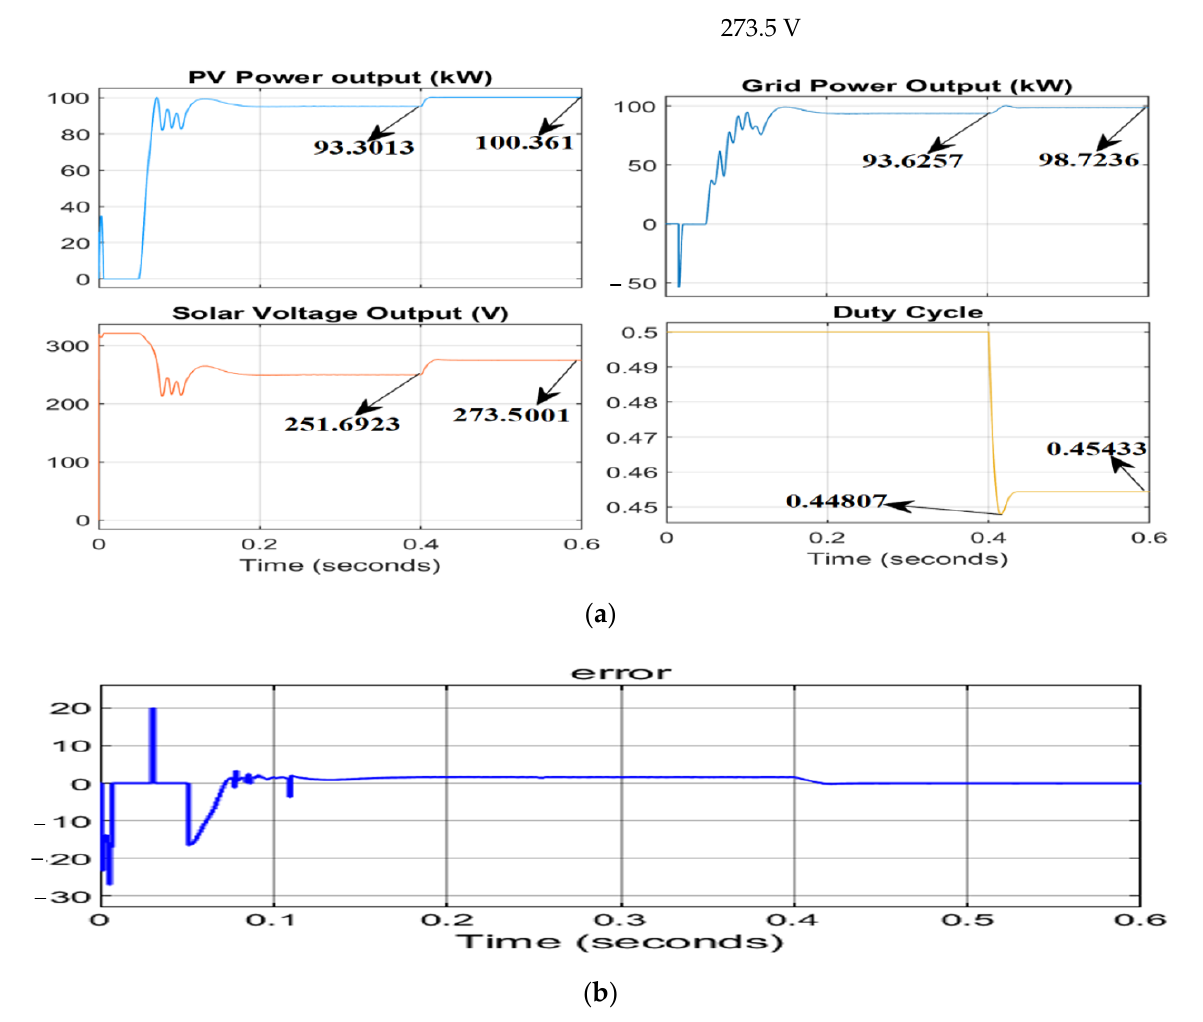
Figure 9. ( a ) PPP tracking; ( b ) regulator reduces error to zero at t = 0.4 s. The simulation response between t = 0.62 and 1.5 s shows that there is a variation in the solar PV irradiance (Figure 10); the irradiance of the sun changed suddenly from 100 W/m 2 to 251.116 W/m 2 within 0.5 s and maintained stability for 0.1 s. It changed 251.116 to 686.7565 W/m 2 within 0.5 s (Figure 10a), and the temperature remained constant at 25 degrees at t = 1.5 s in Figure 10b. The duty cycle continued to change at t = 1.5 s in Figure 10c but remained stable at t = 2.1 s while D = 0.46007. The variation in the irradiation of the sun resulted in the reduction in the solar PV and the grid output power. Moreover, the solar PV output power changed within 0.5 s from 100.361 to 25 kW, and was stable at 69.9254 kW. The grid output power changed from 98.7236 to 28.2 kW and remained